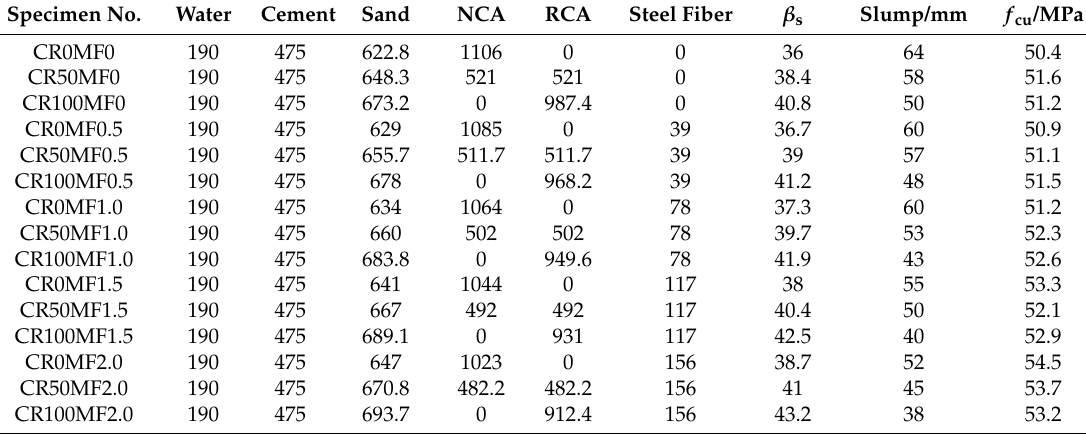
Table 7. Mixture proportions (kg/m 3 ) and test results for new sand content